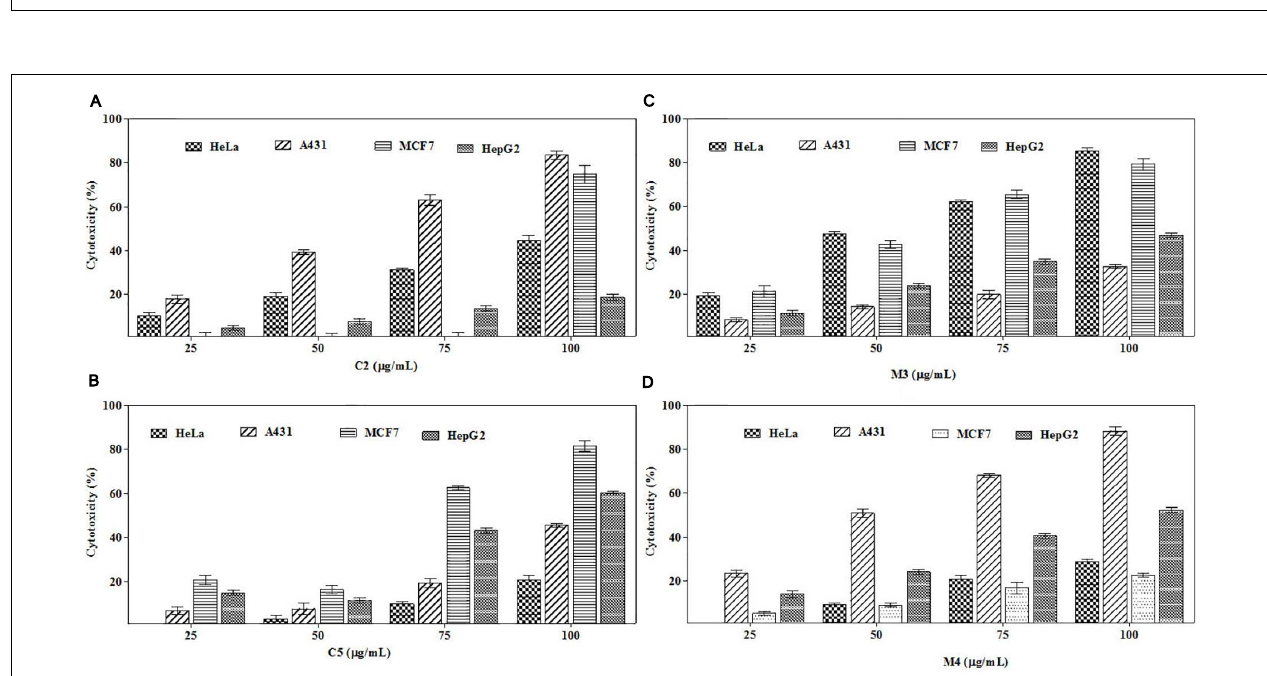
FIGURE 9 | Cytotoxic effects of purified bioactive fractions from B. petrensis culture extracts. The cytotoxic effect was determined against HeLa, A431, MCF-7, and HepG2 cancer cell lines with different concentrations of bioactive fractions: (A) C2, (B) C5, (C) M3, and (D) M4.